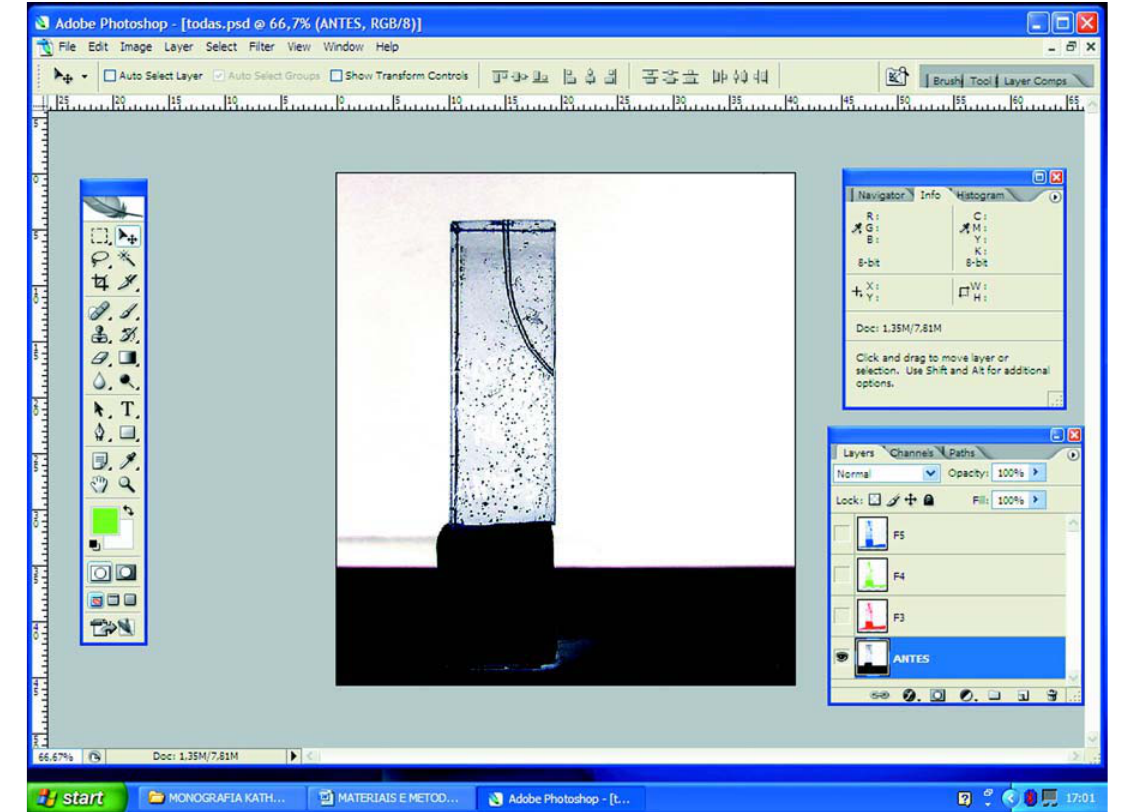
FIGURE 1- Simulated canal before preparation with gray tone inversion in Adobe Photoshop CS2 program